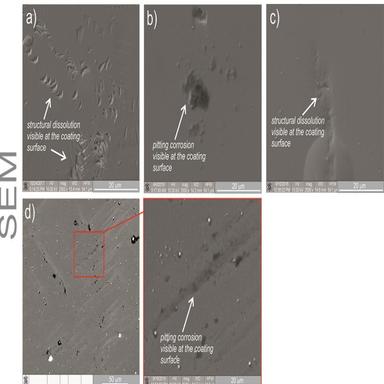
A cross-section image showing the anodic dissolution in the Zr/Zr2N (1:1 ratio) multilayer coating performed by TEM; a) TEM BF image; and b) STEM image.